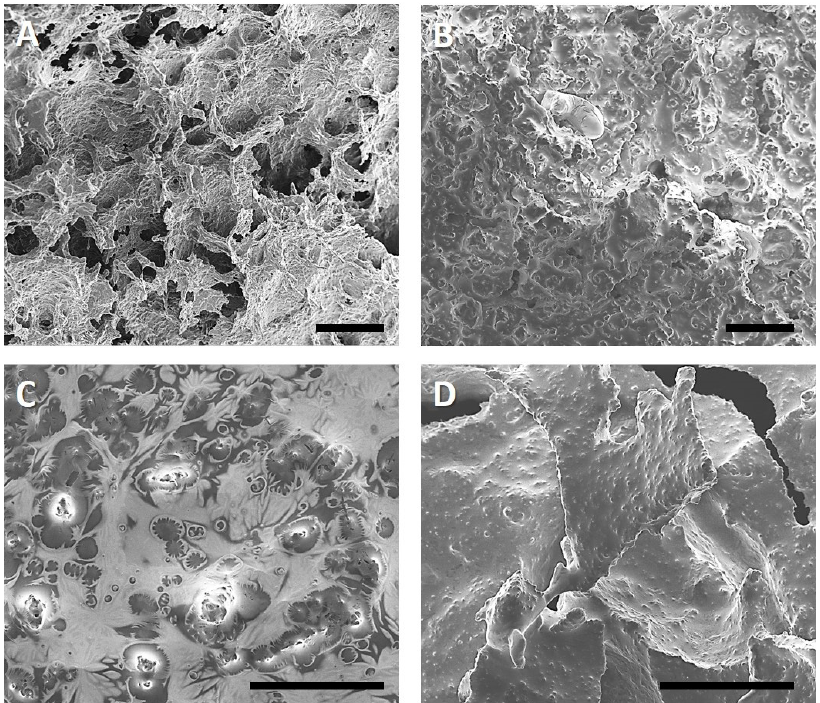
Figure 5. Micrograph obtained using a scanning electron microscope (SEM) of fermented SPI gels after freeze-drying. ( A ) Reference sample, without coconut oil. ( B ) SPI emulsion gel (droplets stabilised with MGP). ( C ) SPI emulsion gel (droplets stabilised with SPI). ( D ) SPI emulsion gel (droplets stabilised with MGP + SPI). Scale bar equals 100 µm.